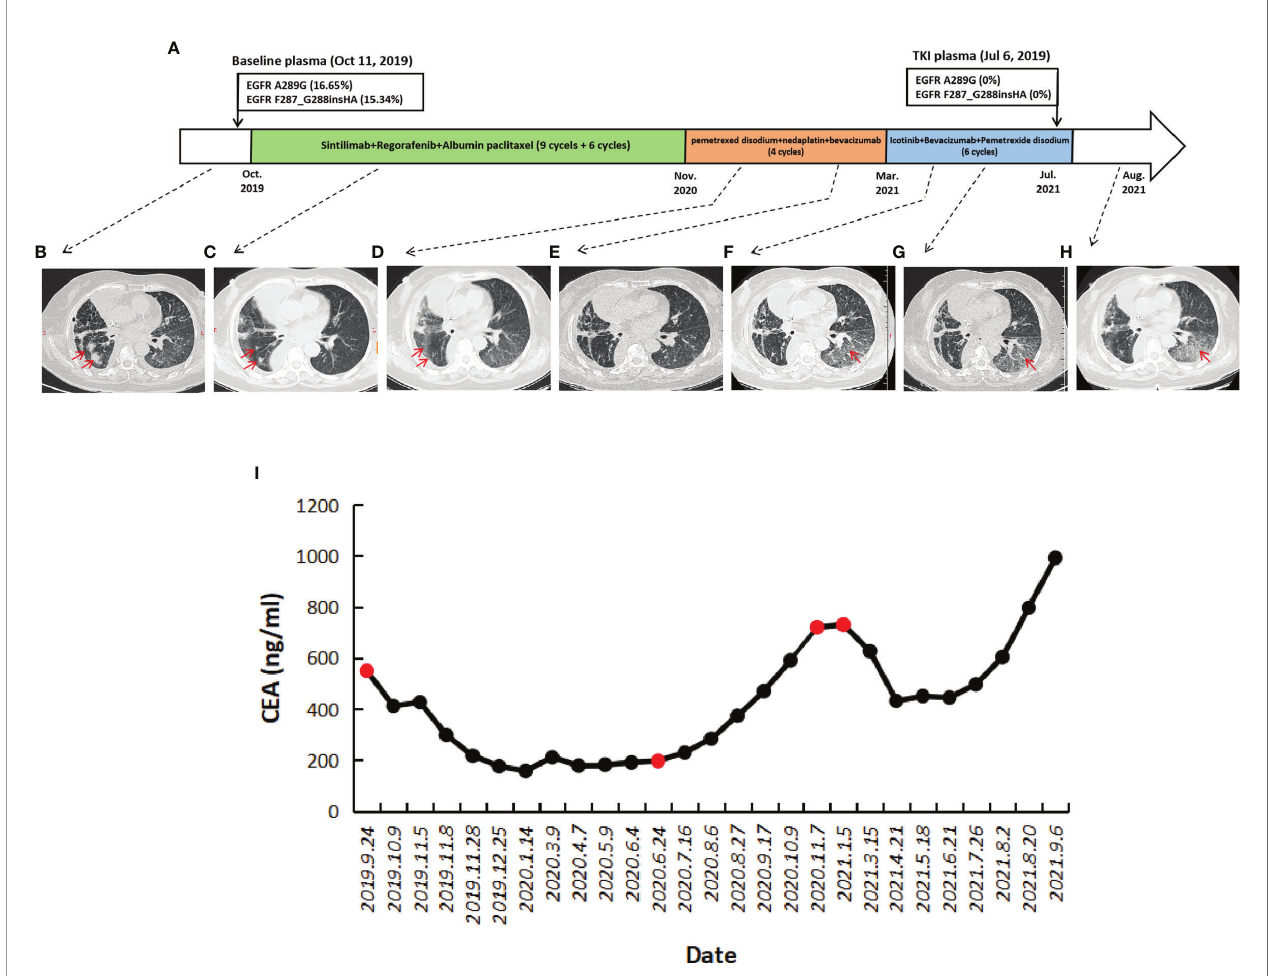
FIGURE 2 | Treatment course and corresponding clinical features of patients after EGFR mutation was detected. (A) The patient received immunotherapy in combination with chemotherapy and antiangiogenic therapy, followed by chemotherapy, and fi nally EGFR-TKI in combination with chemotherapy. From October to December 2019, the treatment effect was the best, and the right lower lung lesion was signi fi cantly reduced. (B) The CT image of the patient before sintilimab in combination with regorafenib and chemotherapy in October 2019. (C) The CT image of the patient after therapy for 2 months in December 2019. CT images from December 23, 2020 (D) and February 5, 2021 (E) were clinical data of the patient receiving chemotherapy again. Mild interstitial changes in the left lower lung were observed during treatment with EGFR-TKI-targeted drugs icotinib (F – H) . (I) The variation CEA from the initial treatment to the end of treatment. CEA level decreased sharply after sintilimab in combination with regorafenib and chemotherapy and reached the lowest point in January 2021. After that, it remained stable for a period of time and began to rise in July 2020, and it peaks in January 2021. After the treatment with icotinib in March 2021, the CEA level of the patient decreased signi fi cantly, remained stable from April to June, and began to rebound in July, with the CEA gradually increasing. The red dots correspond to the CEA level of the patient before each